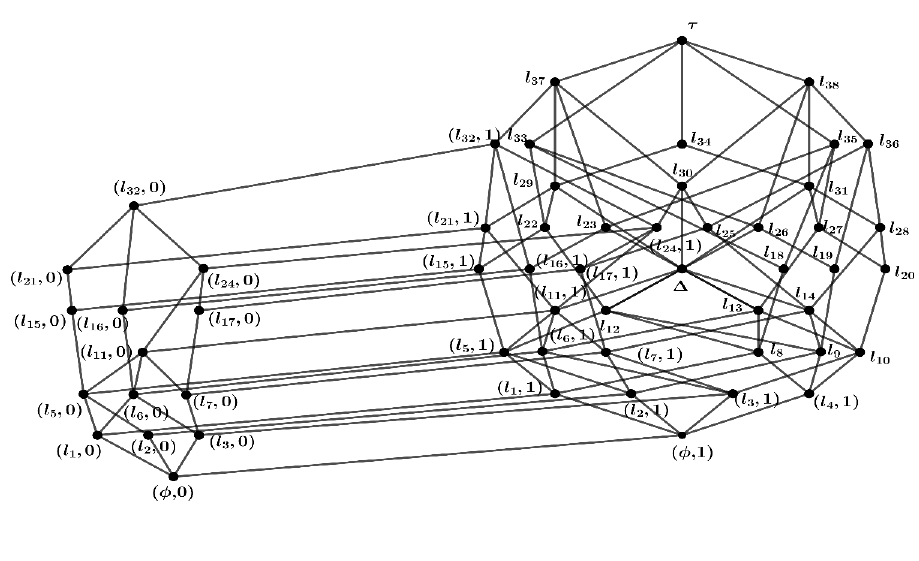
(𝐿 )](𝐼) where 𝐼 = [𝜙, 𝑙 𝑊 4